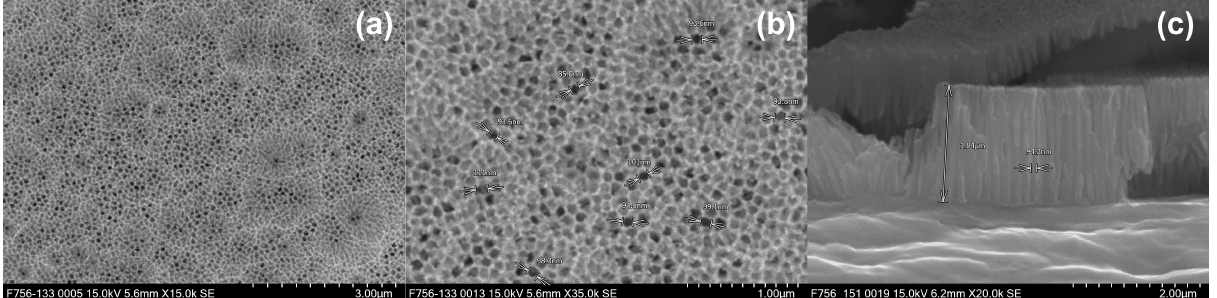
Figure 5. ( a – c ) SEM micrograph of surface and fractured cross-section of the optimized an- odized